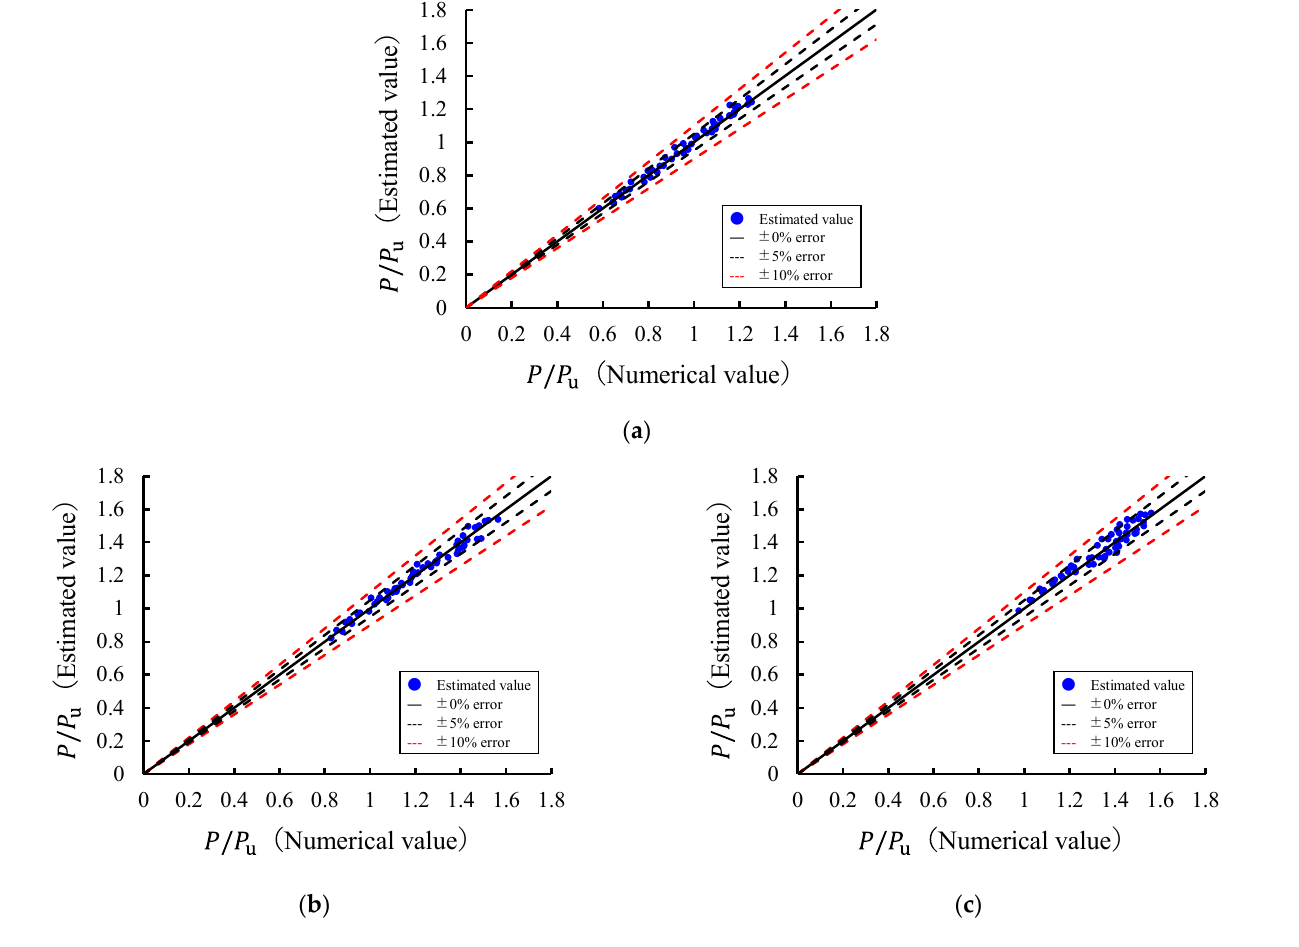
Figure 15. Difference between maximum load bearing capacity from numerical analysis and modified estimation equations: ( a ) L c / L = 0.2; ( b ) L c / L = 0.4; ( c ) L c / L =